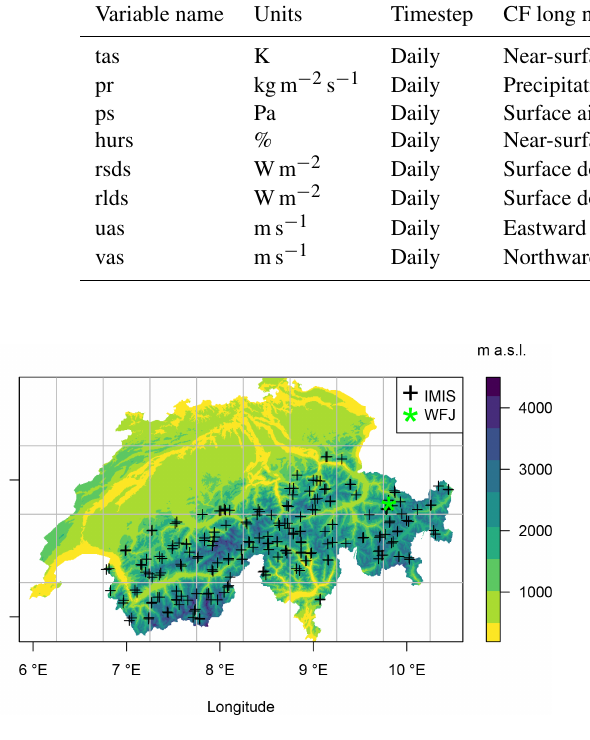
Figure 2. Study domain map with CORDEX EUR-44 grid (44km) overlaid. IMIS stations and the Weissfluhjoch site (WFJ) are indi-